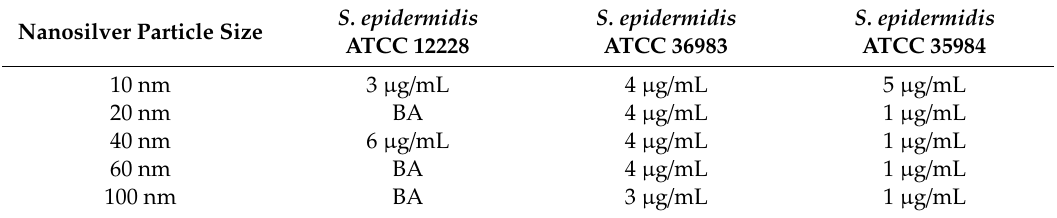
Table 1. MIC values [ µ g / mL] for the S. epidermidis strains examined, depending on AgNPs particle size; BA—activity not